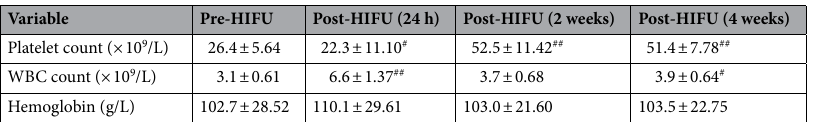
Table 2. Hematological changes pre-HIFU and post-HIFU. HIFU high intensity focused ultrasound, WBC white blood cell. # Compared with pre-HIFU values, p < 0.05. ## Compared with pre-HIFU values, p < 0.001.